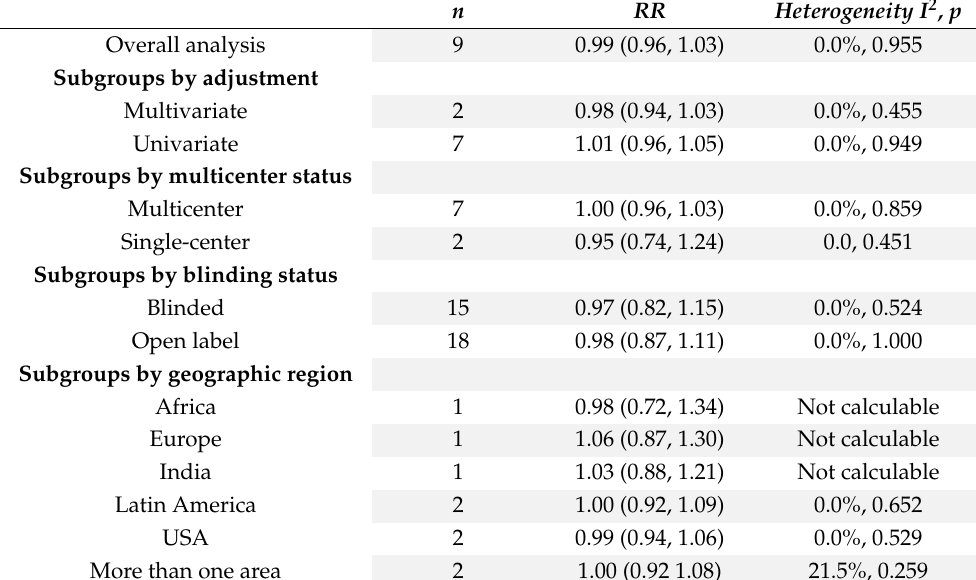
Highlighted rows denote statistically significant